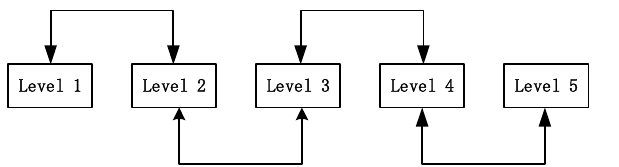
Figure 1. Evolutionary laws of navigational environmental impact factors among levels.